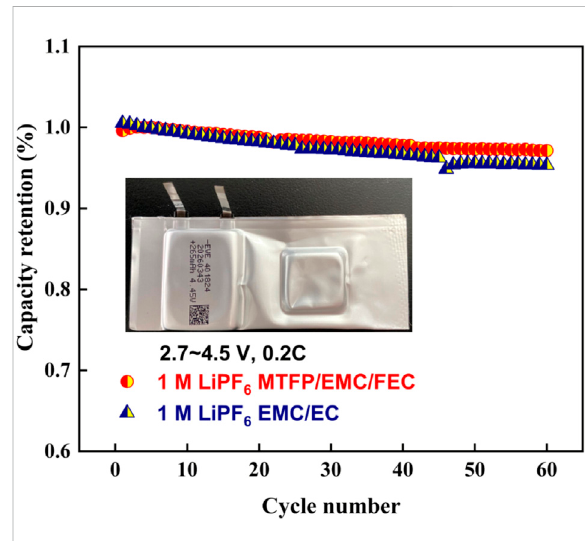
FIGURE 10 Cycling performances of the pouch cells assembled with the 1 M LiPF 6 EMC/EC electrolyte and the 1 M LiPF 6 MTFP/EMC/FEC electrolyte at room temperature at the rate of 0.2